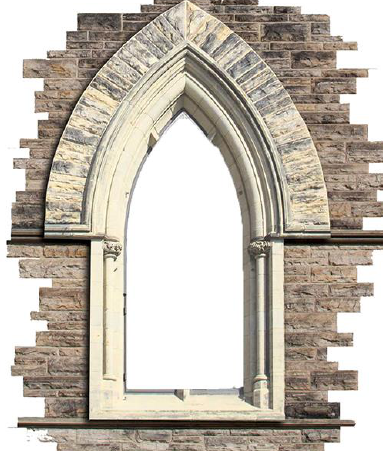
Figure 2. Photogrammetric 3D model. Figure 3. Architectural image target used for